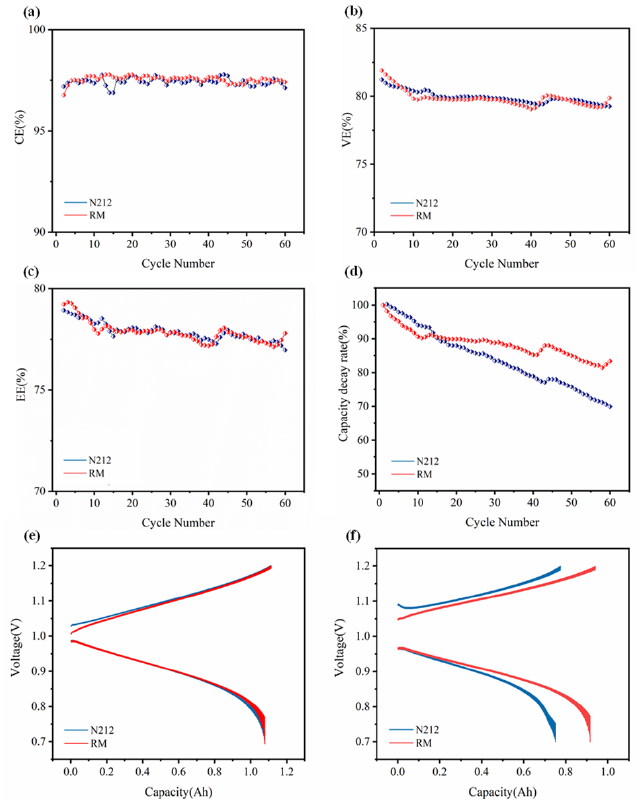
Figure 5. Stable performance of ICRFB assembled with different membranes under 60 cycles at a fixed current density of 140 mA cm − 2 : ( a ) CE, ( b ) VE, ( c ) EE, and ( d ) discharge capacity retention; ( e ) second and ( f ) 60th constant current charge/discharge curves at 140 mA cm − 2 .